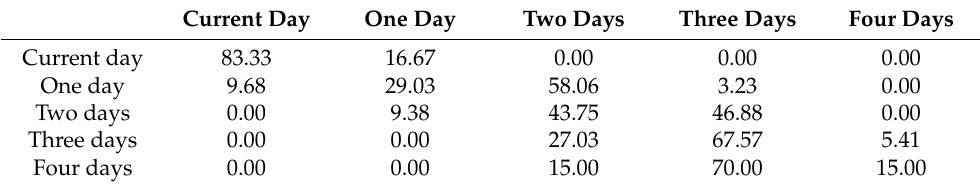
Table 5. Prediction results are based on the ratio of R in RGB values with noise.